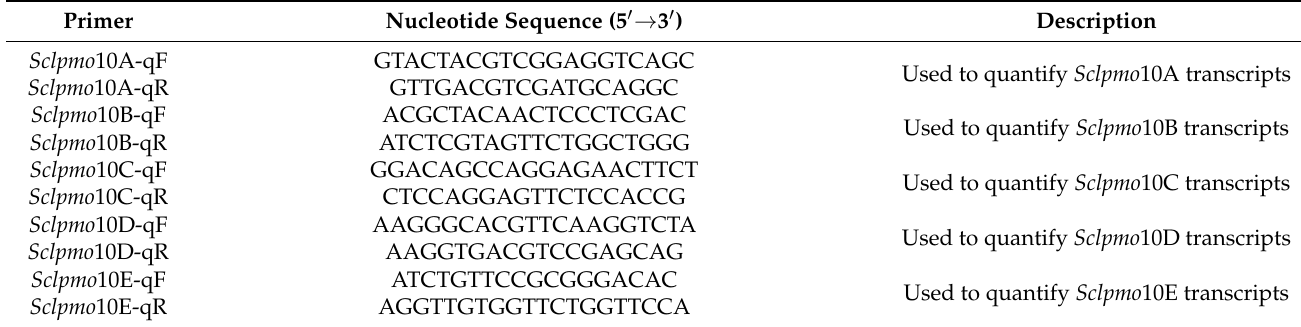
Table 1. The primers used in this